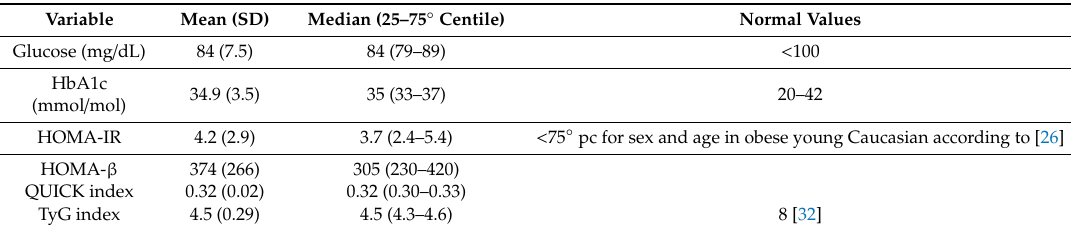
Table 3. Glucose metabolism in obese adolescents. HbA1c, glycated hemoglobin,